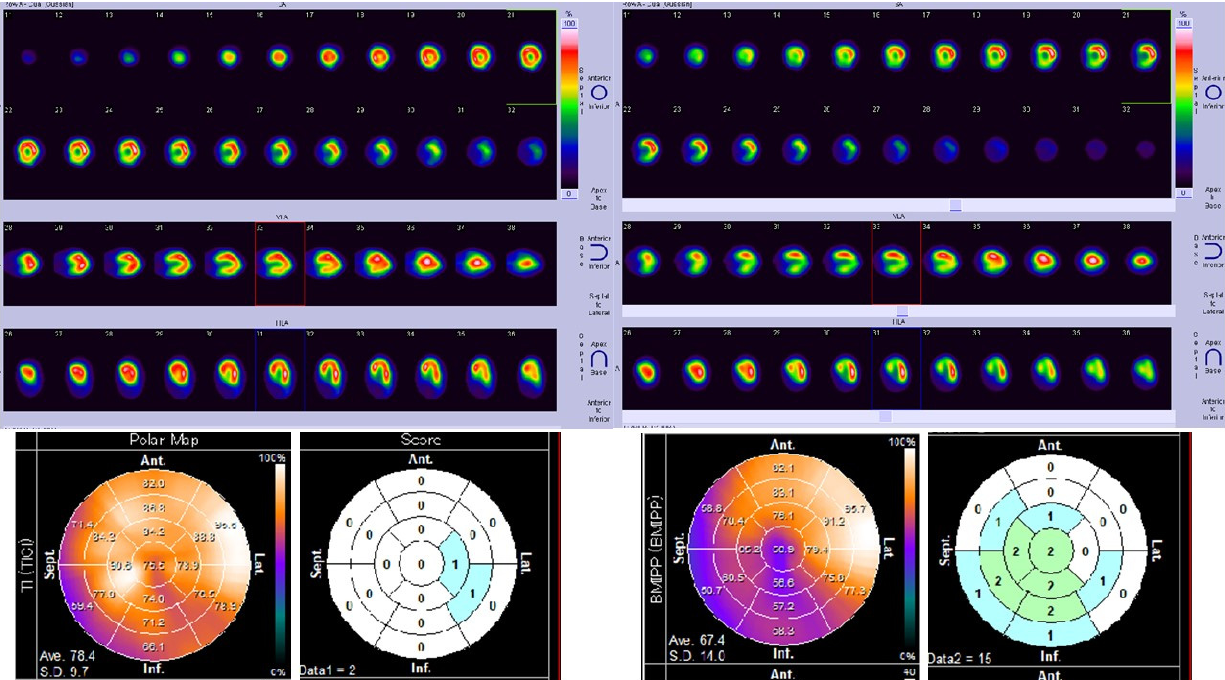
Figure 2. SPECT images, polar maps, and Heart Risk View-S scores of Case E whose LVEF decreased to 48.4%. Left top: SPECT images of 201 Tl perfusion scintigraphy. Left bottom: polar map and scores of 201 Tl. Right top: SPECT images of 123 I-BMIPP metabolism scintigraphy. Right bottom: polar map and scores of 123 I-BMIPP.